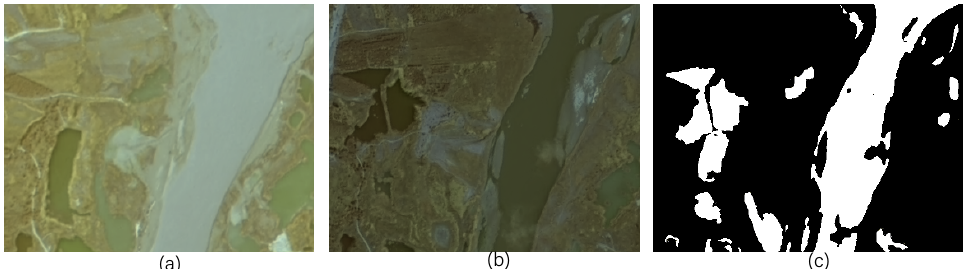
Figure 6. Multispectral images and reference image of Weihe river dataset. ( a ) Image acquired on 19 August 2013. ( b ) Image acquired on 29 August 2015. ( c ) Reference